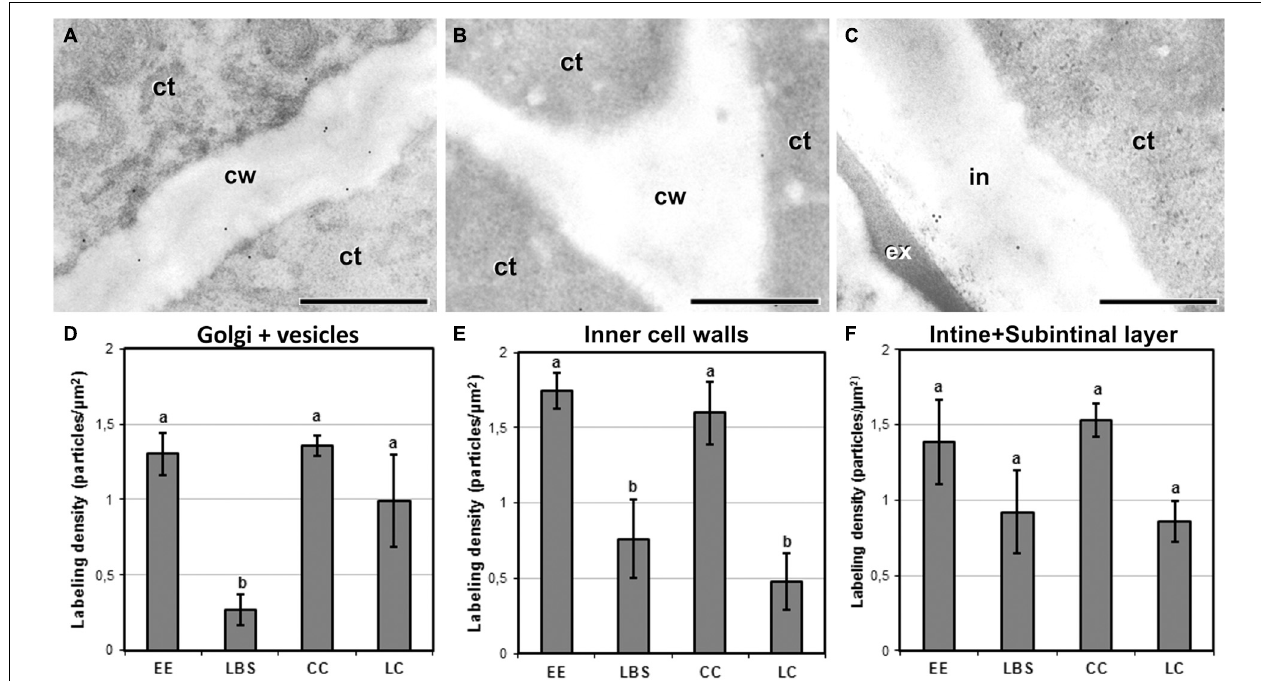
FIGURE 6 | Detection of JIM5 cross-reacting low methyl-esterified pectin by immunogold labeling and quantification in TEM images of 5-day-old microspore cultures. Inner cell wall images of EE (A) and LC (B) . (C) Outer cell wall image of EE. (D) Quantification of JIM5 cross-reacting low methyl-esterified pectin in cytoplasmic Golgi stacks and vesicles. (E) Quantification of JIM5 cross-reacting low methyl-esterified pectin in inner cell walls. (F) Quantification of JIM5 cross-reacting low methyl-esterified pectin in outer cell walls (intine + subintinal layer). Labeling density is expressed in number of particles per µ m 2 . Different letters represent statistically significant differences according to the LSD test. ct, cytoplasm; cw, cell wall; ex, exine; in, intine; m, mitochondrion. Bars: 500